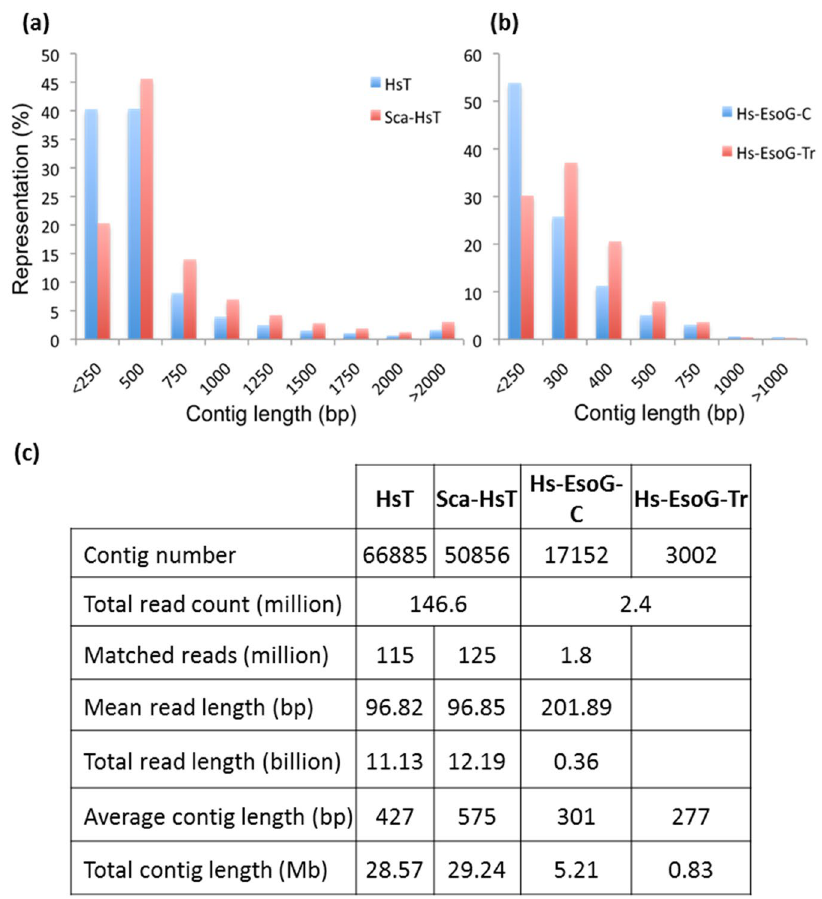
Figure 2. Reads and assembly details of H. scahchtii transcriptome. ( a ) Contig size distribution of H. schachtii transcriptome assemblies with scaffolding (ScaHsT) and without scaffolding (HsT). ( b ) Contig size distribution of H. schachtii esophageal gland transcriptome assemblies using CLC (Hs-EsoG-CLC) or Trinitiy (Hs-EsoG-Tr). ( c ) The details about H. schachtii transcriptome